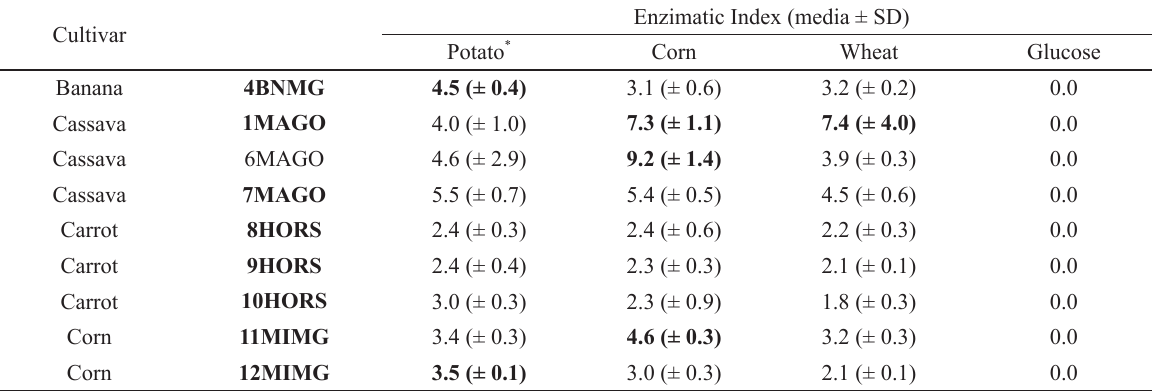
Enzimatic index using a variety of starch